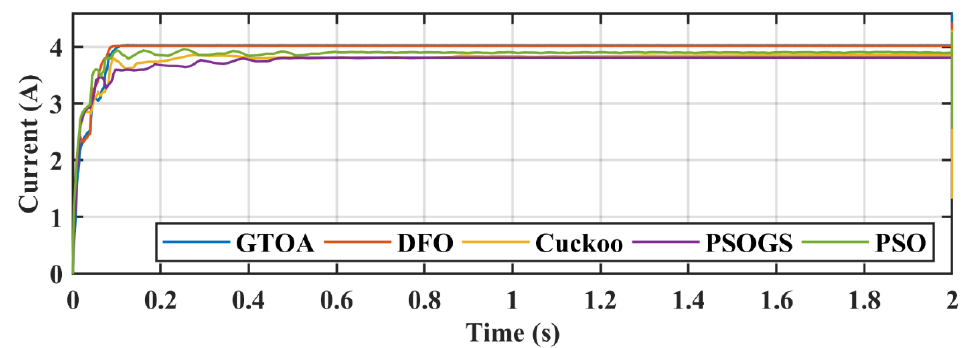
Figure 32. Comparison of current transients of GTOA.